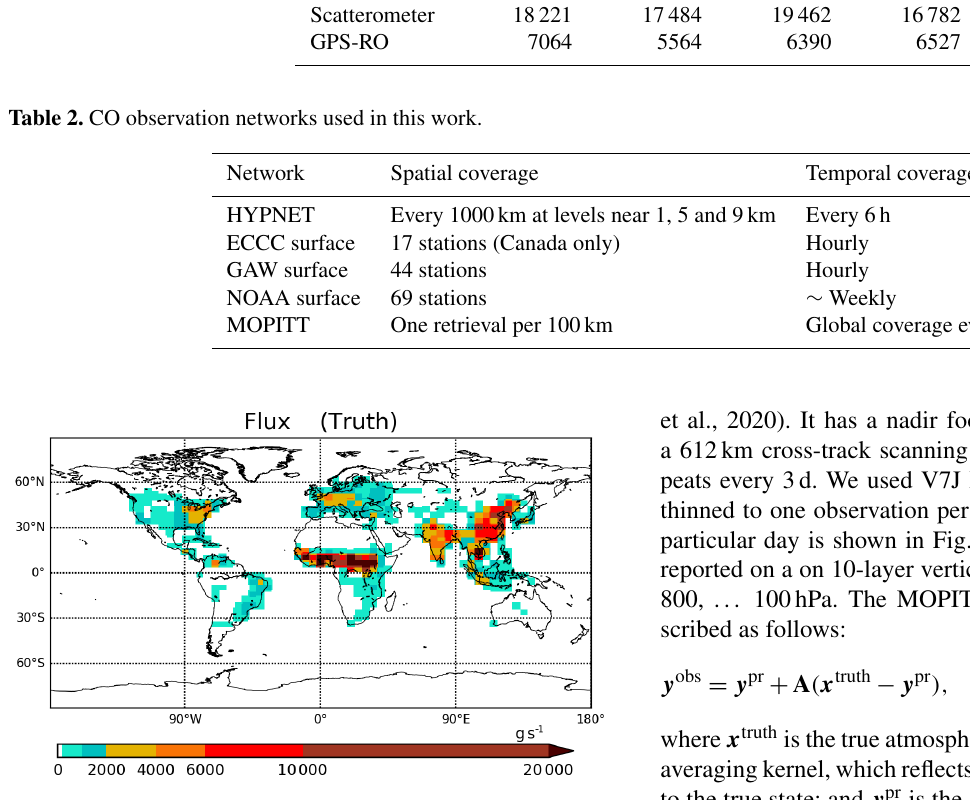
Figure 2. The true CO surface flux field for January 2015.